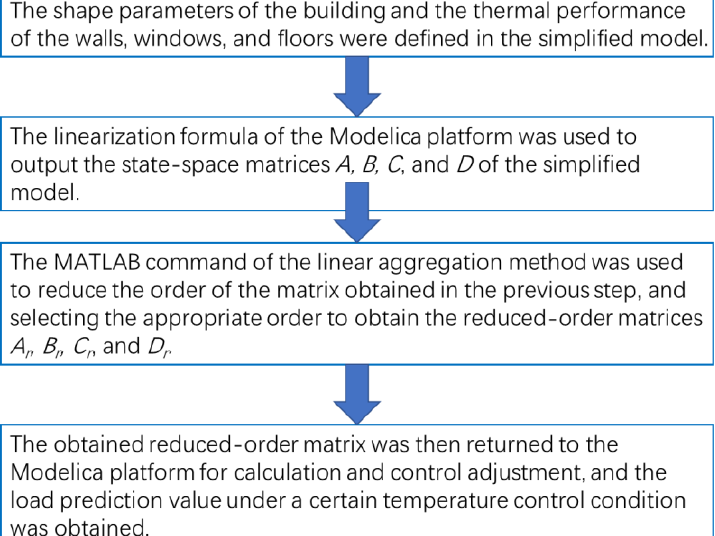
9 of 24 Figure 6. Numerical simplified model. 3.3. Reduced-Order Model (RM) Based on the simplified model, a reduced-order model was established using the re- duced-order method [29]. The order-reduction method uses mathematical means to trans- form the original model from high-order to low-order, from complex to simple, and to ensure that the simplified model output can approximate the mathematical processing of the original model output. If a high-order process can be approximated by a low-order model, using the low-order approximation model to design the control system can signif- icantly simplify the calculation process and improve calculation speed [30]. In this study, the linear aggregation method was used for order reduction in a simplified model [31]. Aggregation combines the state variables of a system and uses a smaller set of state vari- ables to describe the system model [32]. In a reduced-order model, making a reasonable